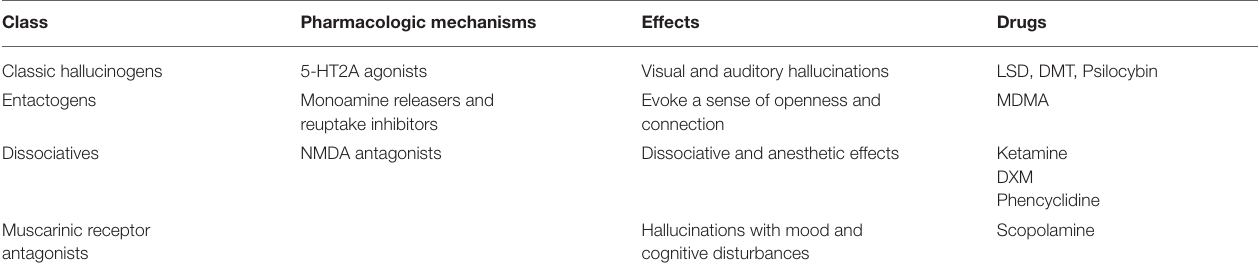
TABLE 1 | Classification of hallucinogens.